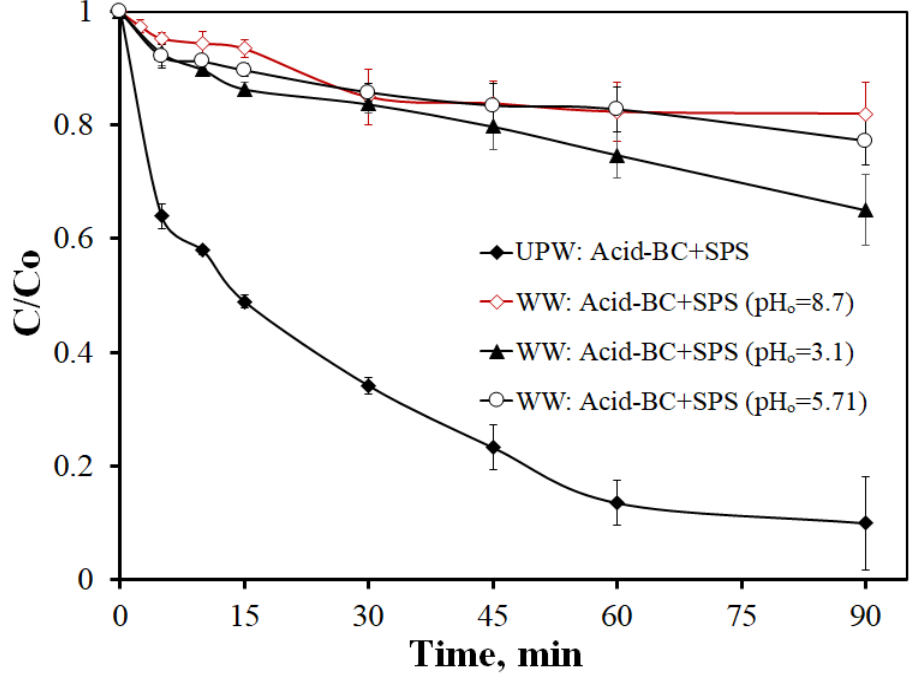
Figure 9. Effect of wastewater (WW) on LOS degradation at several pH values. Experimental con ‐ ditions: (LOS) = 250 μ g/L, (SPS) = 250 mg/L, (acid–BC) = 90 mg/L.